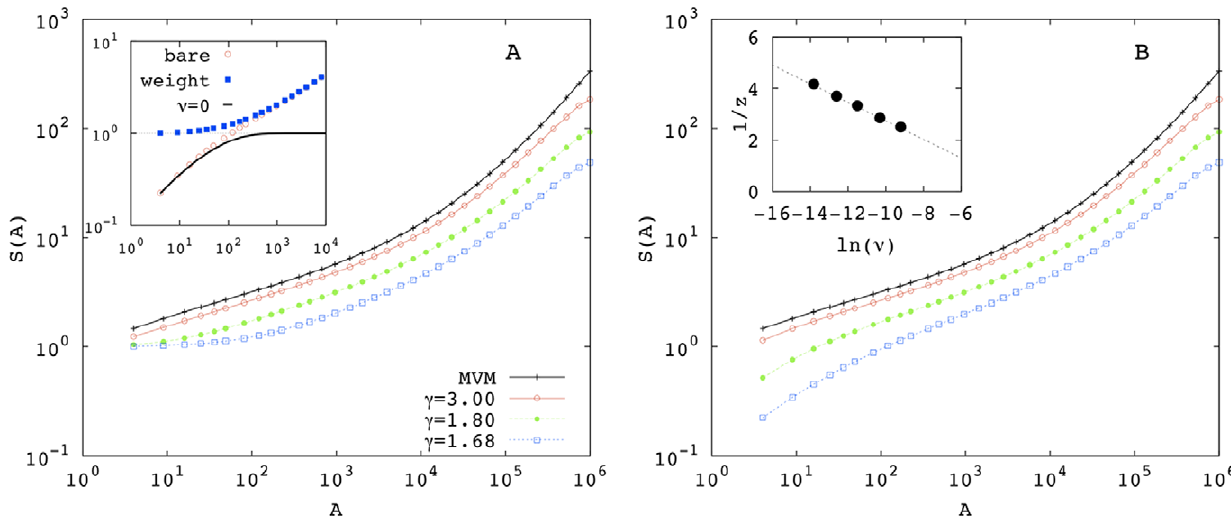
Figure 4. SARs for the MCP for various c as labeled: (a) with weighted averages Eq. (5) and (b) with bare averages Eq. (4). Inset of (a): for c ~ 1 : 68 , comparison among bare and weighted averages for n ~ 10 { 5 with the bare average for v =0. Notice the flattening of the weighted curve at short scales and the equivalence of both averages at larger scales. Inset of (b): 1/ z vs ln( n ) , the straight line shows formula Eq. (2) with fitted values m ~{ 0 : 36 and q ~{ 0 : 86 . The exponents z were estimated as the minimum of the local slopes of the species-area curves.